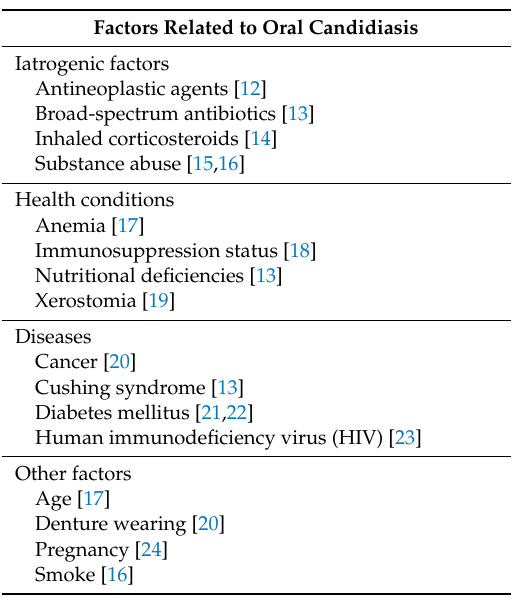
Table 1. Factors related to oral candidiasis